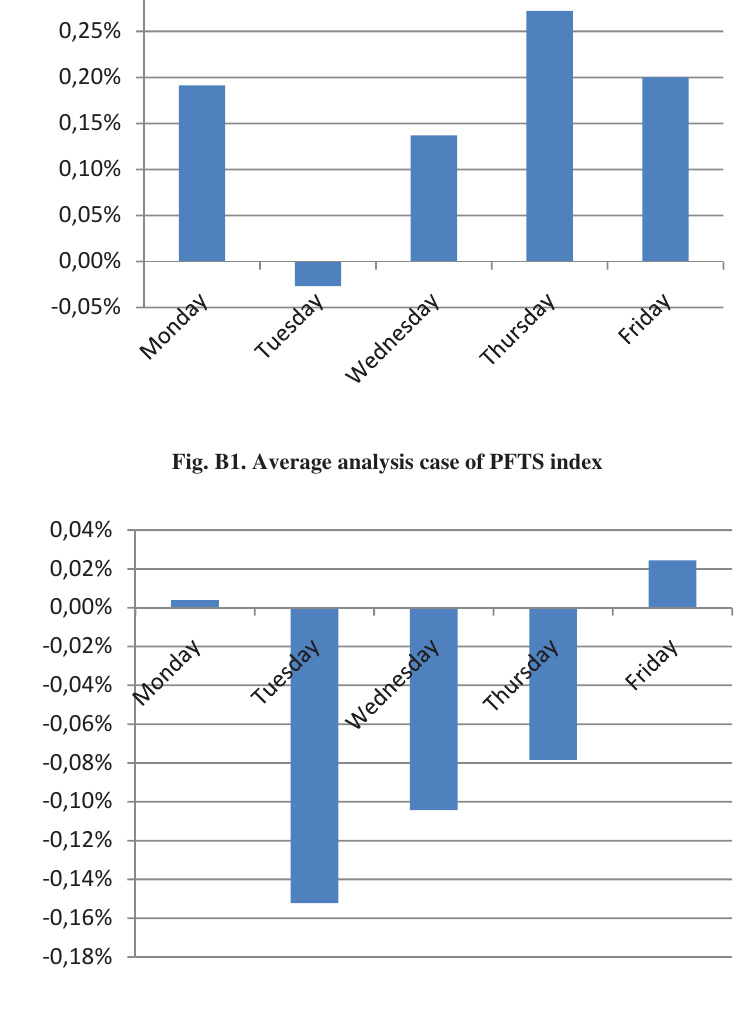
Fig. B2. Average analysis case of UX index